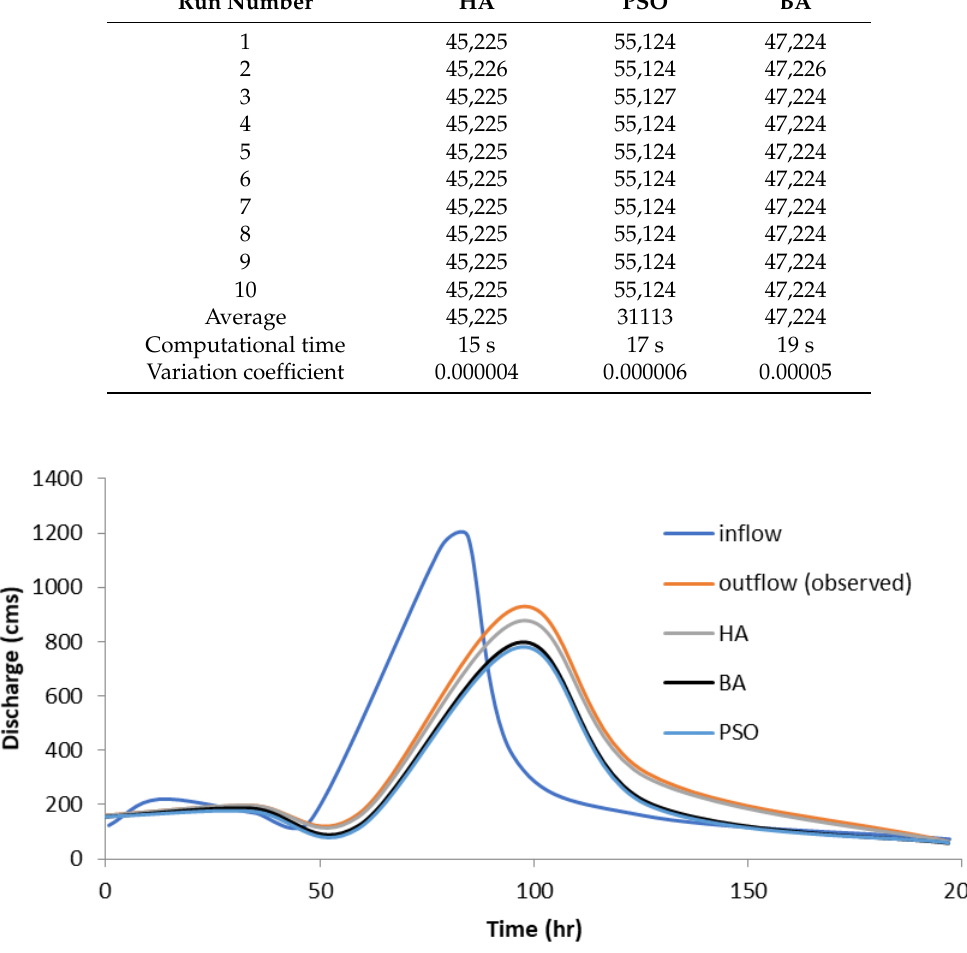
Figure 5. Extracted hydrograph for Viessman and Lewis flood based on 4PMM.